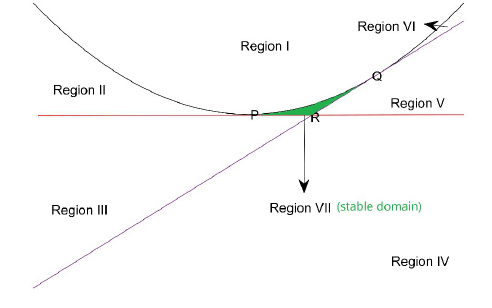
Figure 2. The distribution of seven regions in the plane of parameters (A,